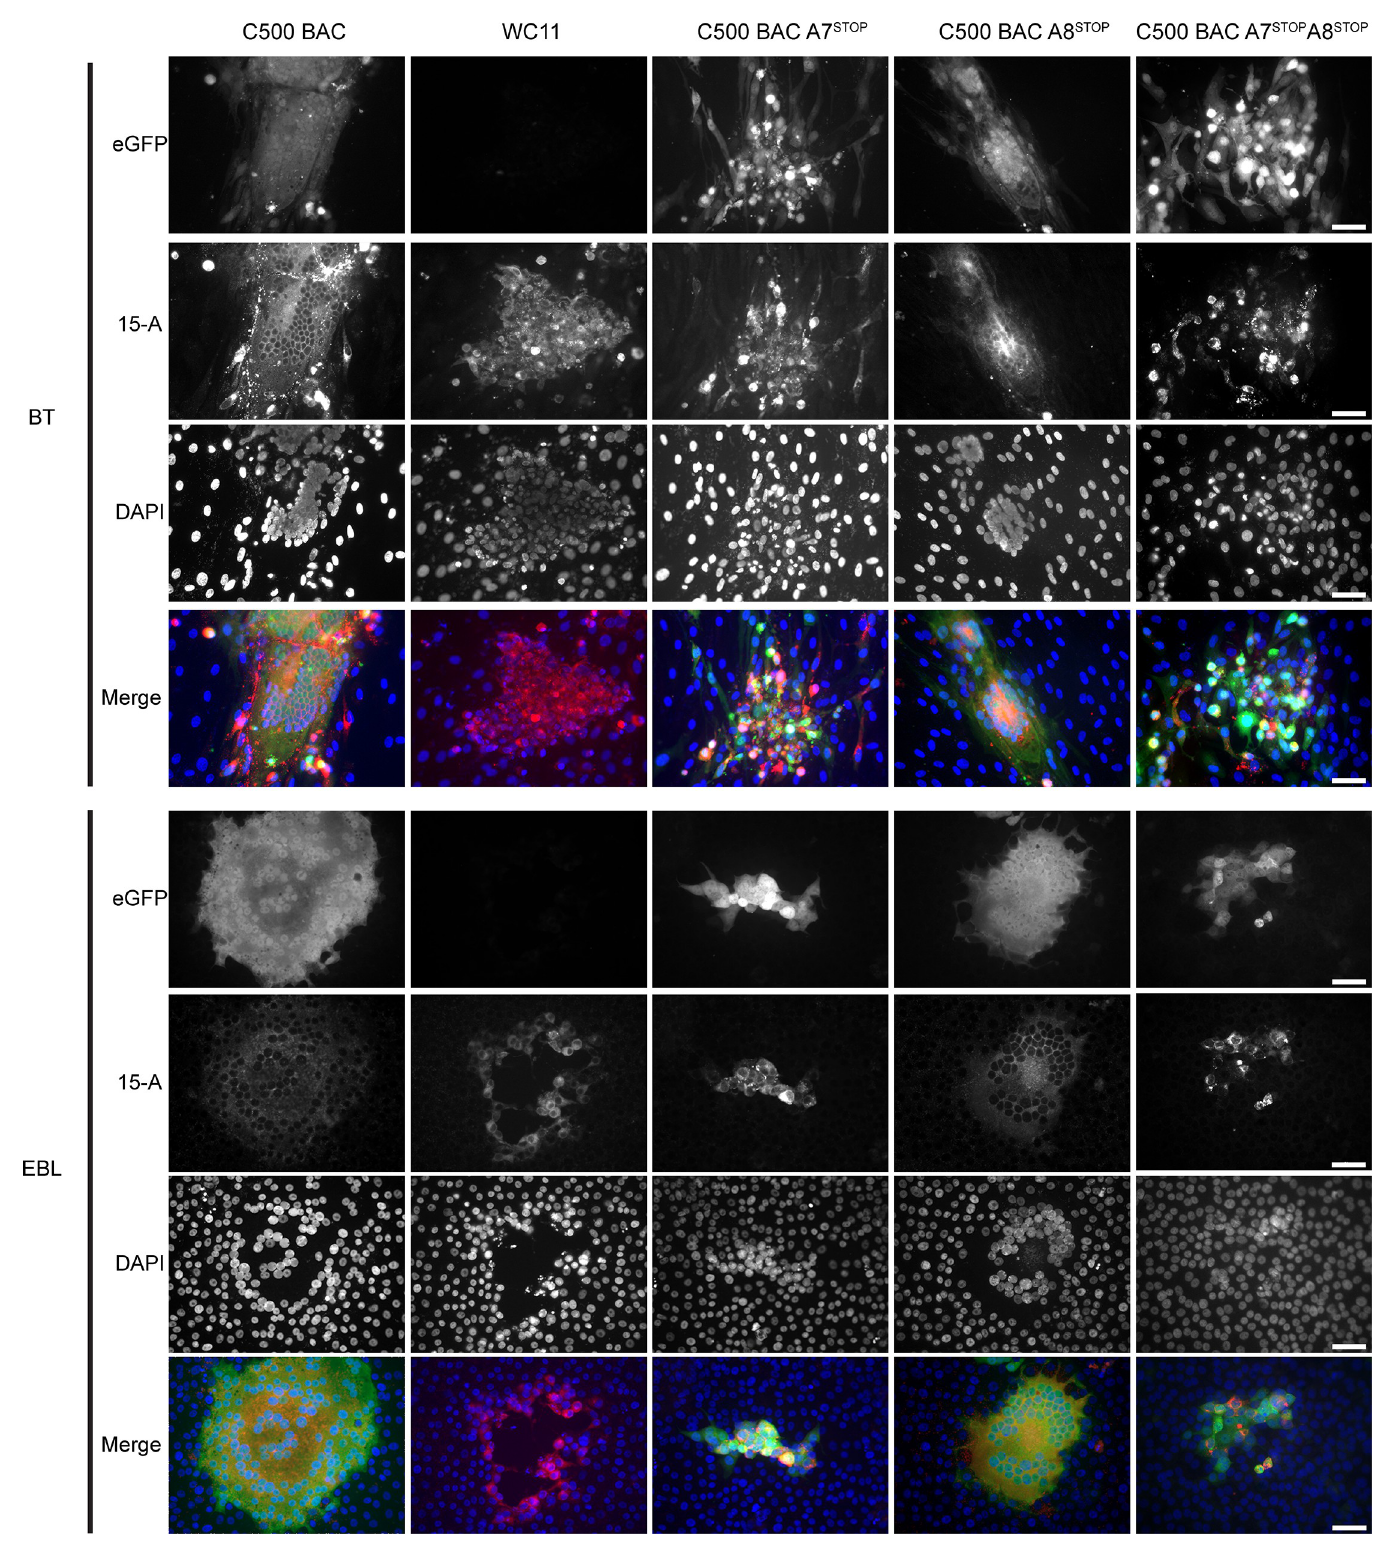
Fig 4. Impaired syncytia formation in the absence of A7 expression. BT or EBL cells grown on glass coverslips were inoculated with C500 BAC + WT, BAC + A7 STOP-207 , BAC + A8 STOP-159 , BAC + A7 STOP-207 A8 STOP-159 or WC11 in presence of 0.6% CMC. At day 4 post-infection, cells were stained for glycoprotein complex gp115 (mAb 15-A; red in Merge) and DNA (DAPI; blue in Merge). Representative images are shown. Scale bars = 50 μ m. https://doi.org/10.1371/journal.ppat.1008405.g004 PLOS Pathogens| https://doi.org/10.1371/journal.ppat.1008405 March 16,